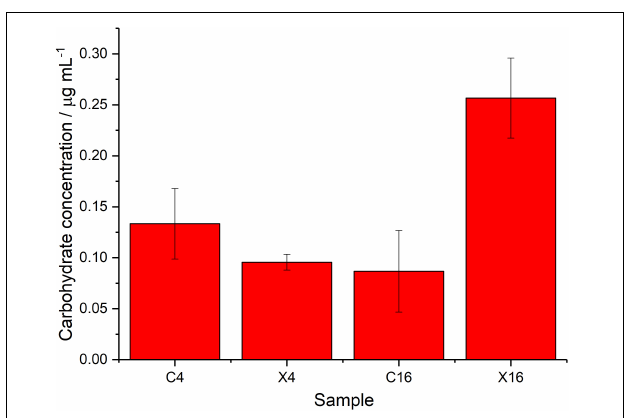
FIGURE 5 | Total cell carbohydrate concentrations measured using Sigma-Aldrich kit, samples include controls (C), and irradiated (X) at day 4 and 16, bars are the mean values from 3 measurements and error bars denote standard